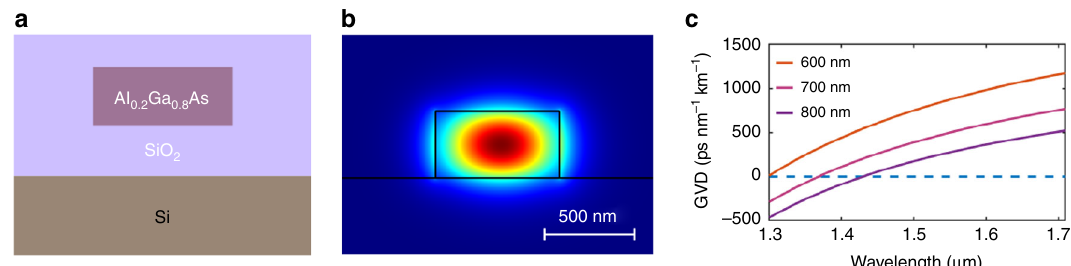
Fig. 1 Waveguide design and dispersion engineering. a Schematic drawing of the AlGaAsOI waveguide cross section; b simulated intensity distribution of the waveguide fundamental TE mode for comb generation; c simulated GVD of 400-nm-thick AlGaAsOI waveguides with different widths.